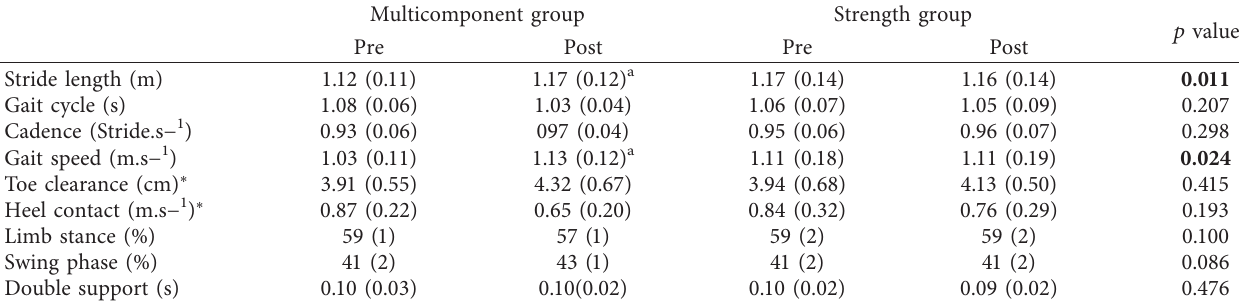
Table 2: Gait parameters for multicomponent and strength groups at pretraining and posttraining. Multicomponent